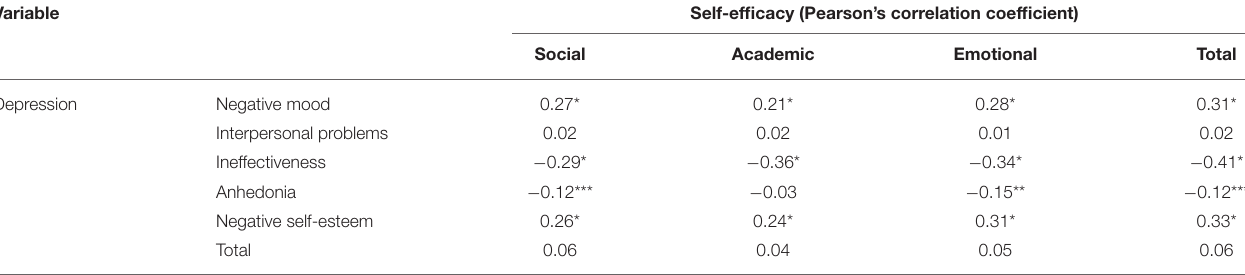
TABLE 4 | Correlation between depression and self-efficacy and their dimensions’ scores among children ( n = 321).